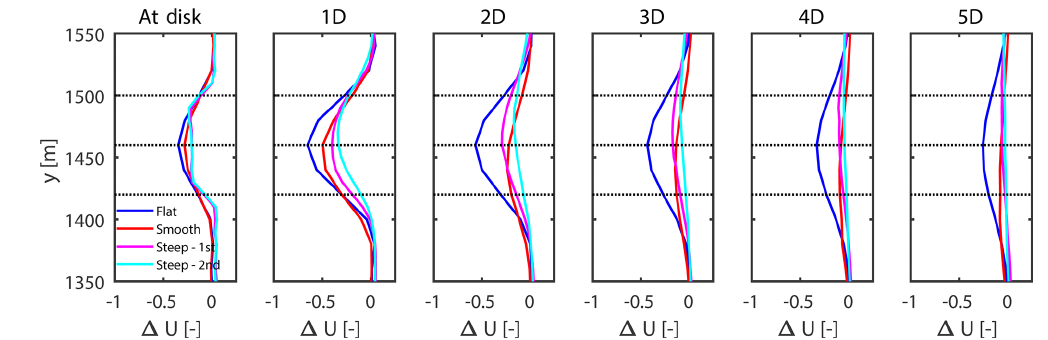
Figure 9. Lateral profiles of streamwise velocity deficit for different cases.